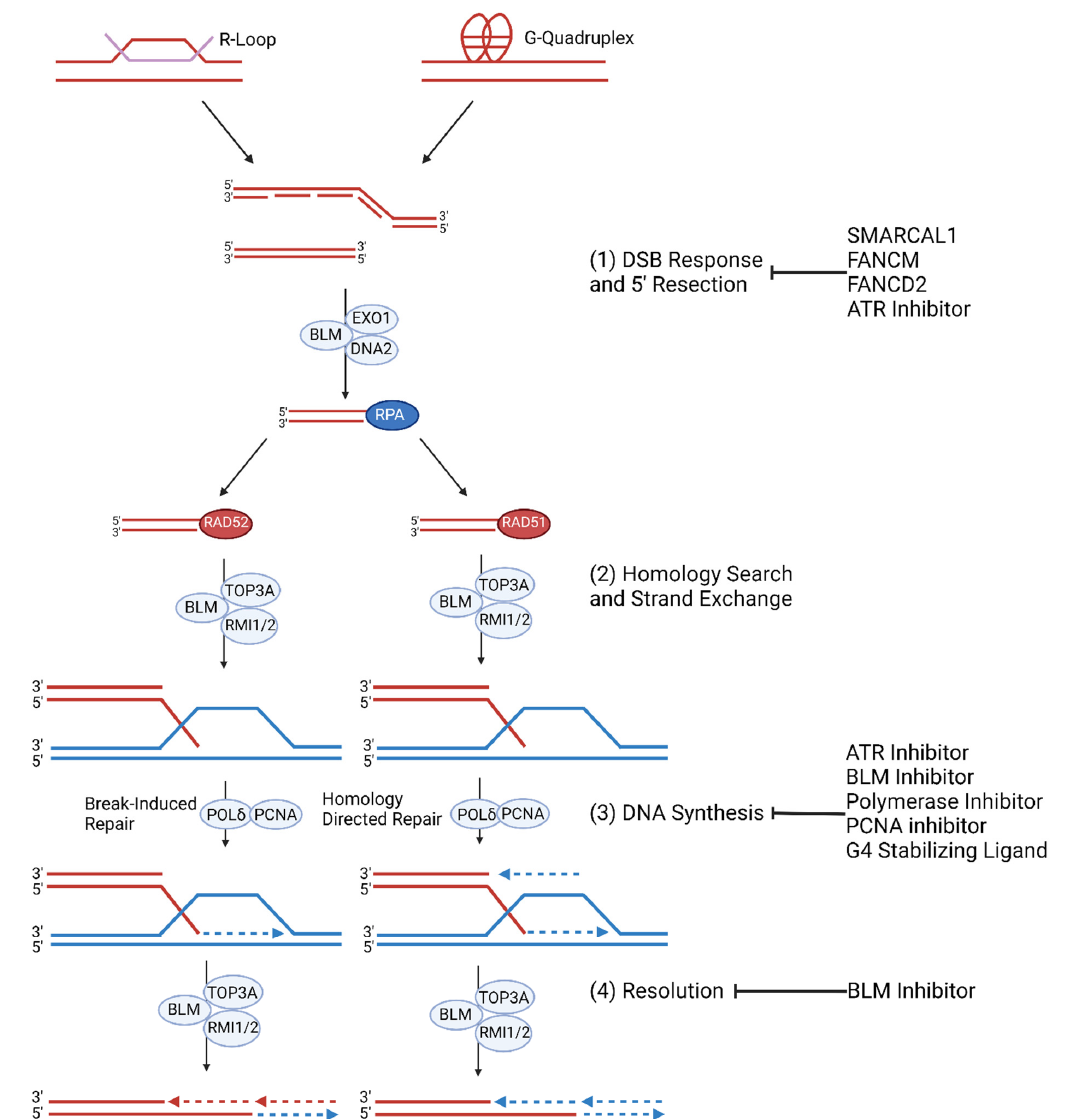
Figure 2. ALT Replication Stress and Molecular Mechanism. (1) Replication stress at telomeres is regulated by SMARCAL1 and FANCM and FANCD2. ALT cells are prone to replication stress which leads to spontaneous DNA synthesis processes. G-quadruplexes and R-loop formation at telomeres trigger replication stress which result in stalled or collapsed replication forks [74,75]. If the replication fork is not reinitiated during S/G2 phase, then mitotic DNA synthesis (MiDAS) of telomeres can occur. (2) The collapsed replication fork may be repaired by RAD52 mediated BIR or RAD51 mediated HR. (3) Telomeric MiDAS-mediated re-initiation leads to conservative DNA synthesis mediated by the BIR pathway when damaged sequences share homology with template DNA. HR- mediated re-initiation leads to semi-conservative DNA synthesis [76]. (4) Extended telomere ends are resolved by BLM [77,78].